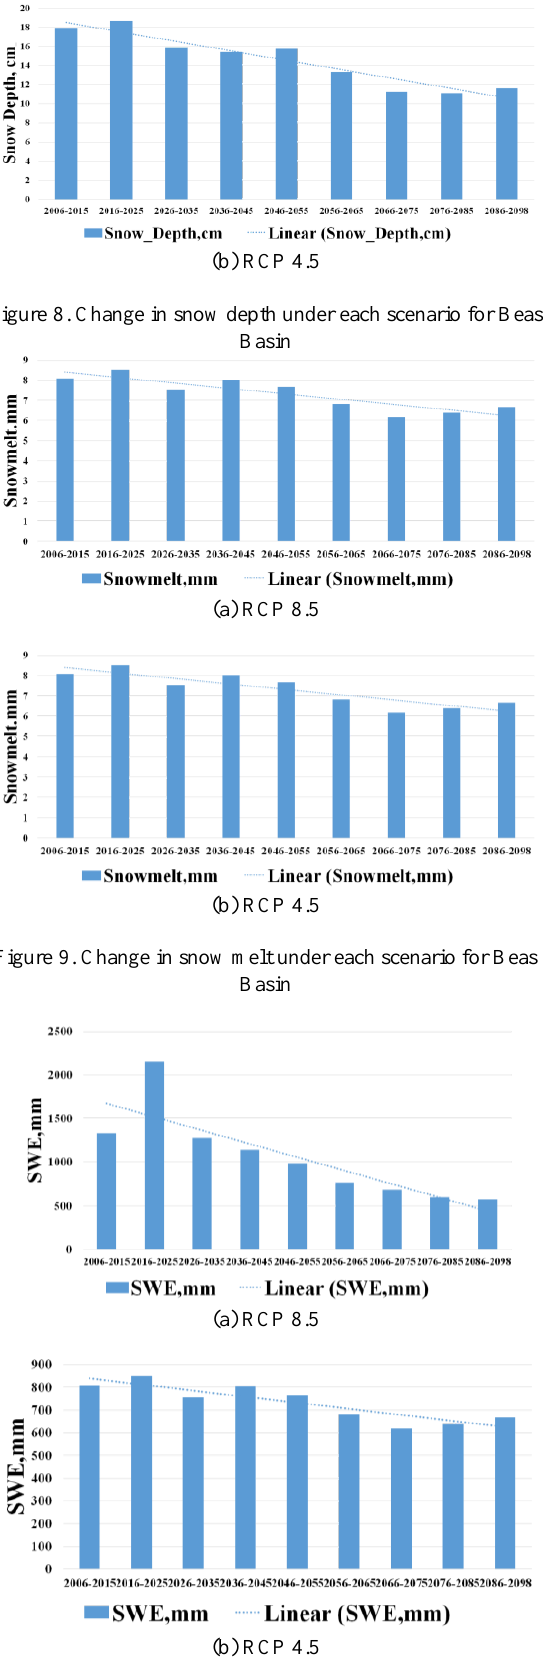
Figure 10. Change in snow water equivalent under each scenario for Beas Basin